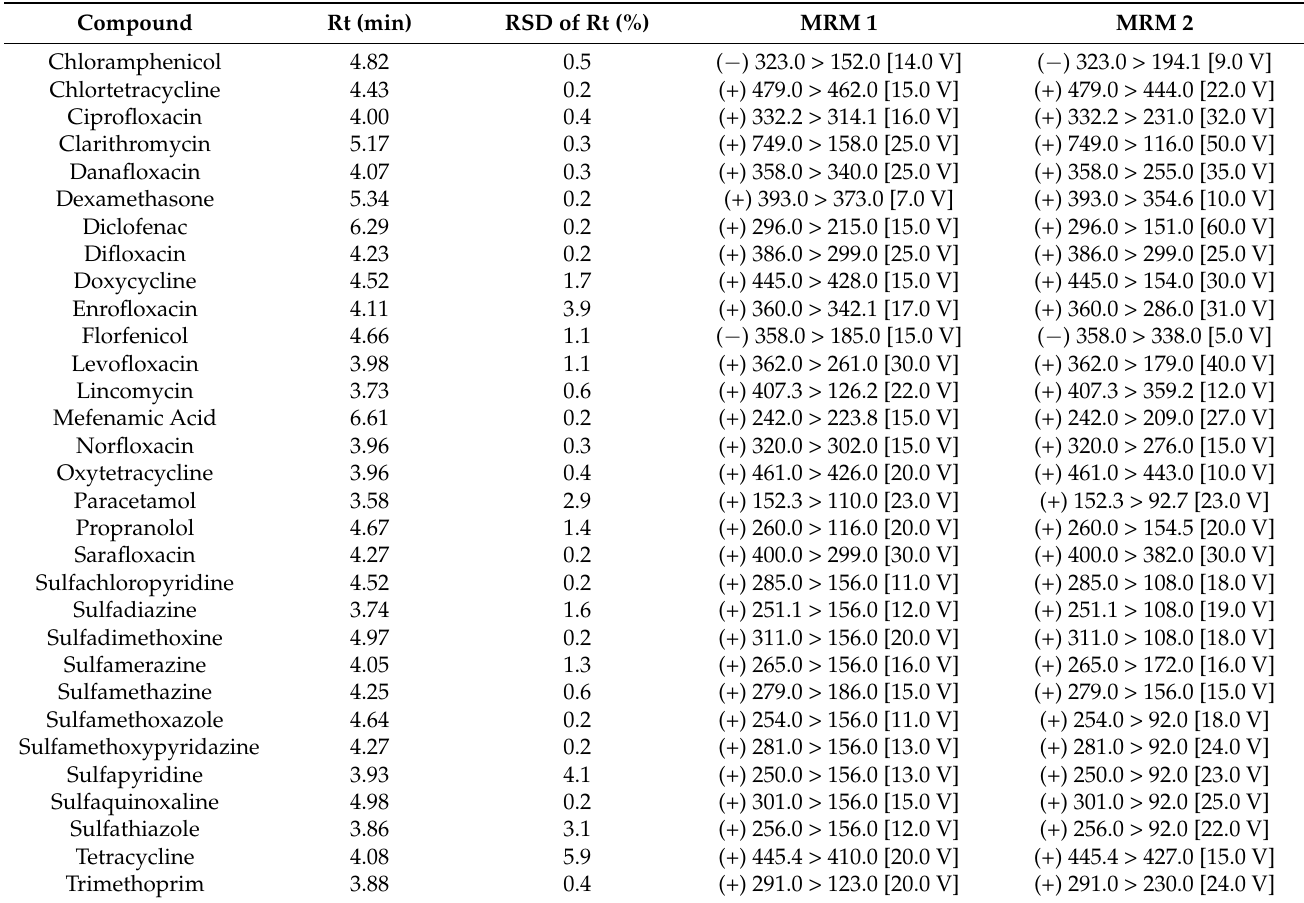
Table 3. Retention time (Rt) and multiple reaction monitoring (MRM) runs 1 and 2 employed for pharmaceutical